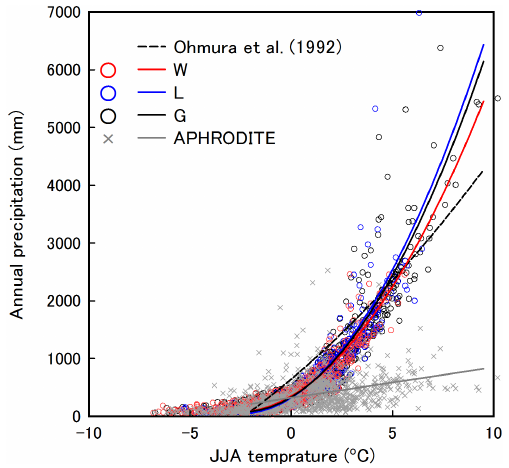
Figure 8. Relation between summer (JJA) temperature and annual precipitation at G-average (black circles), L-average (blue circles), and W-average (red circles) elevations and APHRODITE averaged from 1979 to 2007 (grey crosses). Fitted curves of each data set are plotted and shown by the respective colour. The fitted curve derived by Ohmura et al. (1992) is shown by the black dashed